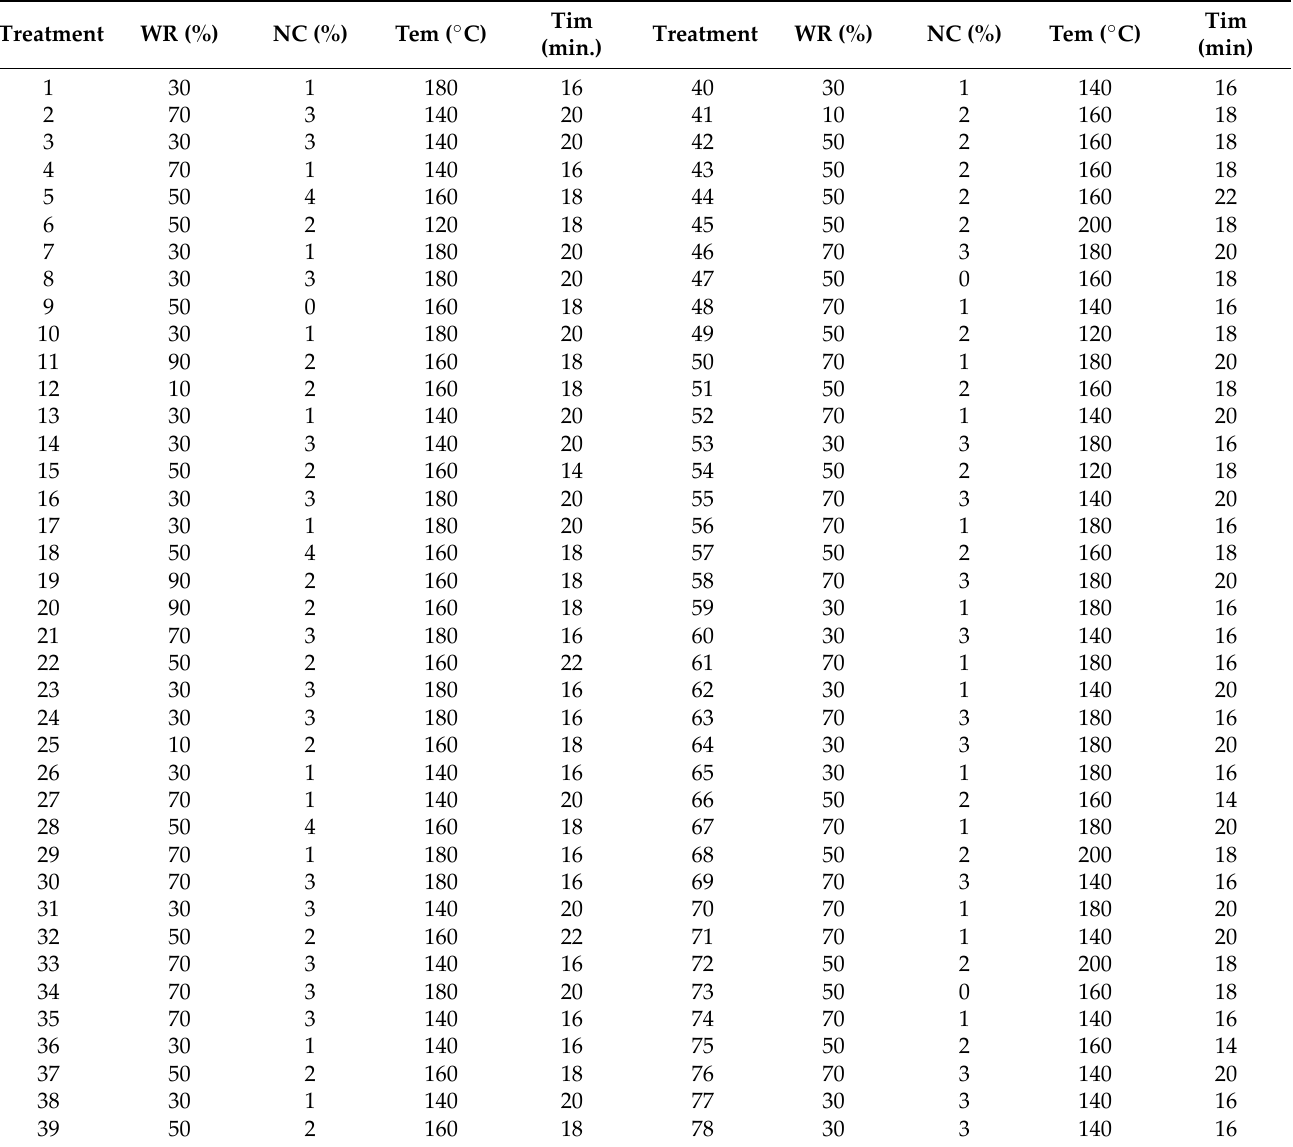
Table 2. Combinations of conditions of making the test